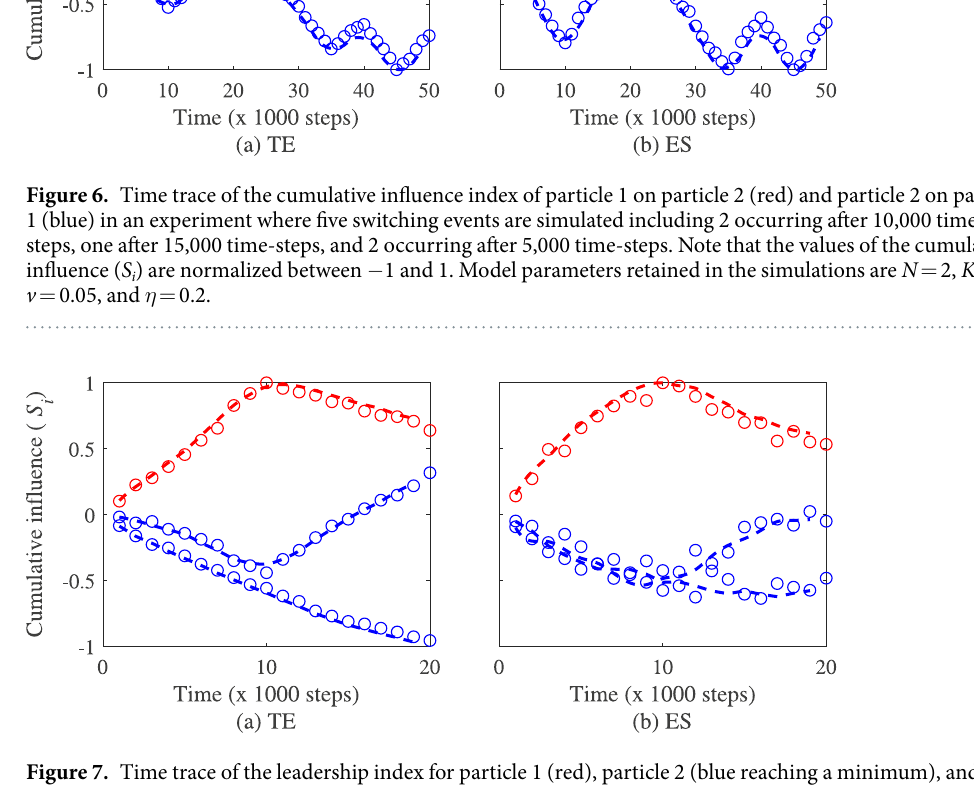
Figure 7. Time trace of the leadership index for particle 1 (red), particle 2 (blue reaching a minimum), and particle 3 (blue decreasing) in an experiment where a single switching event is simulated and each particle is set to interact in average with a single one. Note that the values of the cumulative influence ( S i ) are normalized between − 1 and 1. Model parameters retained in the simulations are N = 3, K = 1, v = 0.05, and η =